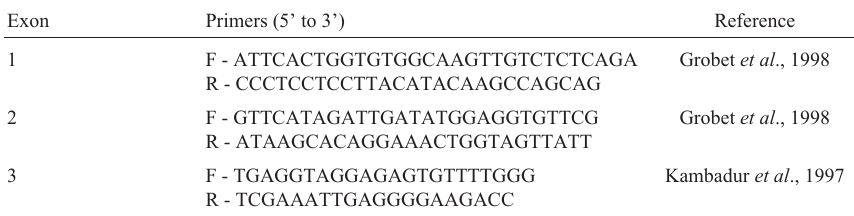
Table 1 - Sequence of the forward (F) and reverse (R) primers used for the amplification and sequencing of buffalo myostatin exons. Exon Primers (5’ to